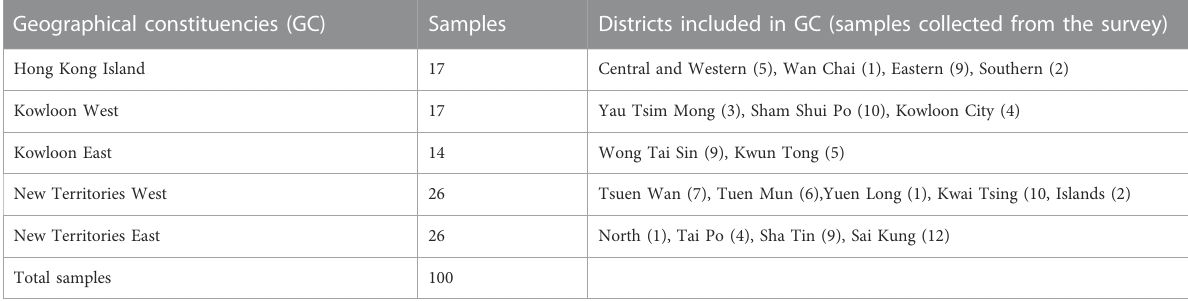
TABLE 1 The Sample size of the survey according to geographical constituencies. Geographical constituencies (GC)